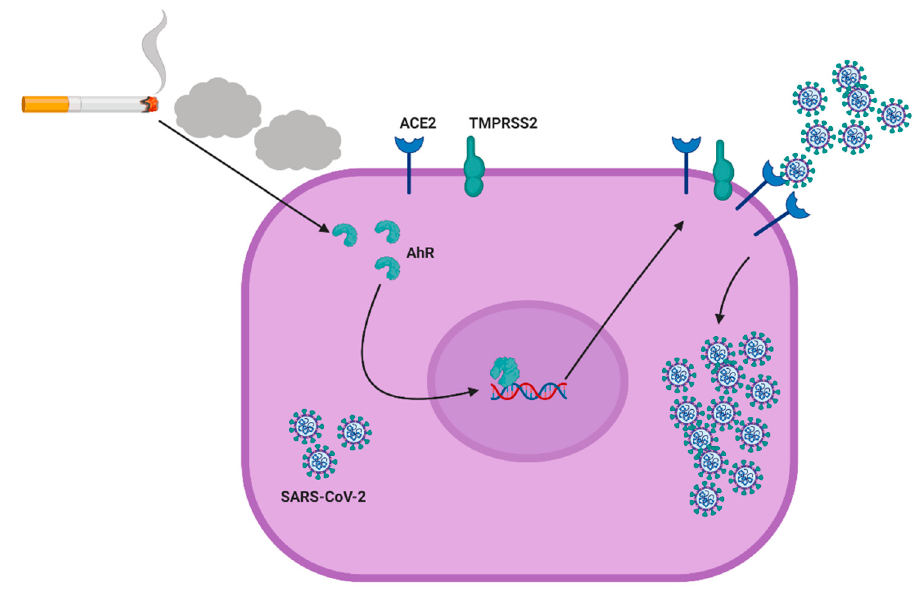
Figure 6. Proposed scheme for the mechanism involved in cigarette smoke-induced enhancement of severe acute respi- ratory syndrome coronavirus 2 (SARS-CoV-2) infection in human gingival epithelial cells. Cigarette smoke activates aryl hydrocarbon receptor (AhR) in human gingival epithelial cells, which increases the surface levels of angiotensin-converting enzyme 2 (ACE2). Increased expression of ACE2 facilitates SARS-CoV-2 infection of the oral epithelial